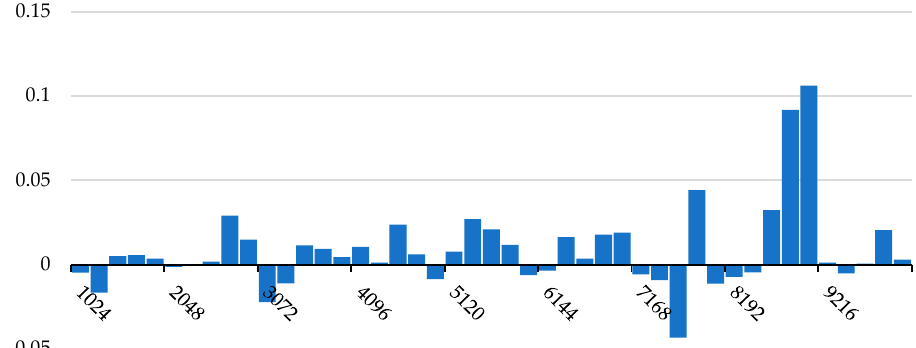
Figure 6. Differences in classification accuracy before and after leaf–wood separation correspond to different numbers of sampling points.